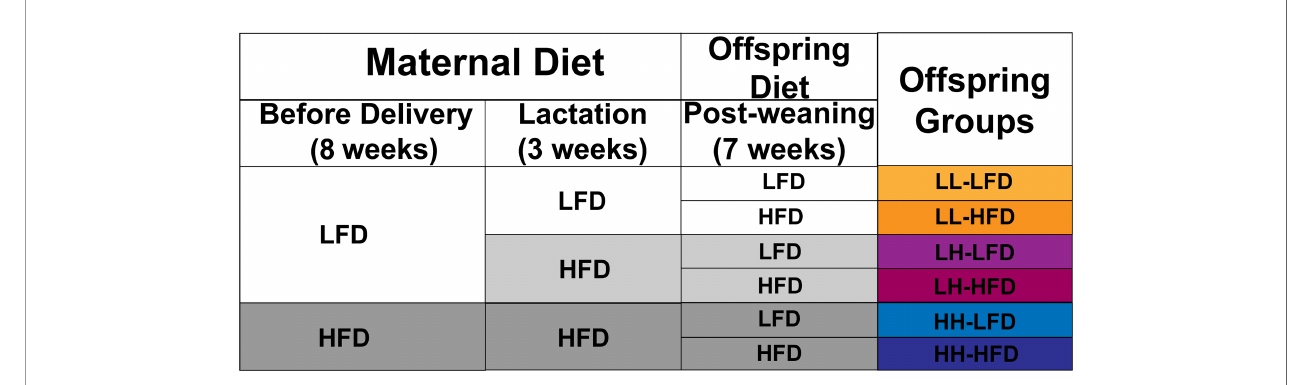
FIGURE 1 | The animal experimental schedule. Before mating, fi ve-week-old ICR female mice were fed control LFD (10% kcal fat) or HFD (45% kcal fat with sucrose) for 5 weeks. The dams received the same diets during gestation. Dams fed gestation LFD received LFD or HFD, and dams fed gestation HFD received HFD during the lactation. The litters were adjusted to 10 pups per litter on the day of delivery. At weaning, three groups were produced: LL, offspring from both gestation and lactation LFD-fed dams; LH, offspring from gestation LFD-fed and lactation HFD-fed dams; or HH, offspring from both gestation ad lactation HFD-fed dams. And then, the male offspring from each group were selected to receive post-weaning LFD or HFD until they were 10 weeks